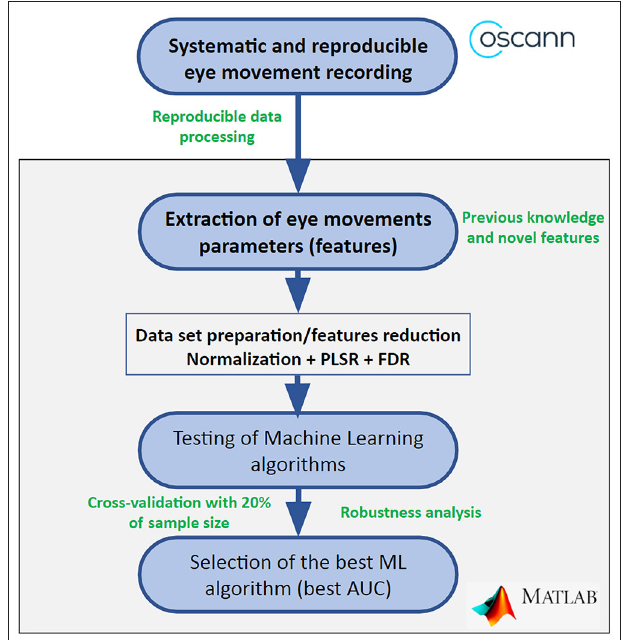
FIGURE 1 | Flow chart to find the most suitable combination between eye movement features and machine learning algorithm. AUC, area under the curve; FDR, Fisher discriminant ratio; ML, machine learning; PLSR, partial less square regression.